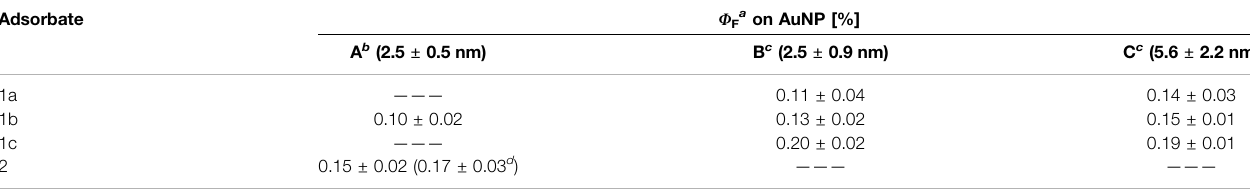
TABLE 1 | Average fl uorescence quantum yields ( Φ F ) of porphyrin adsorbates on AuNPs with different diameters and size distributions. Adsorbate